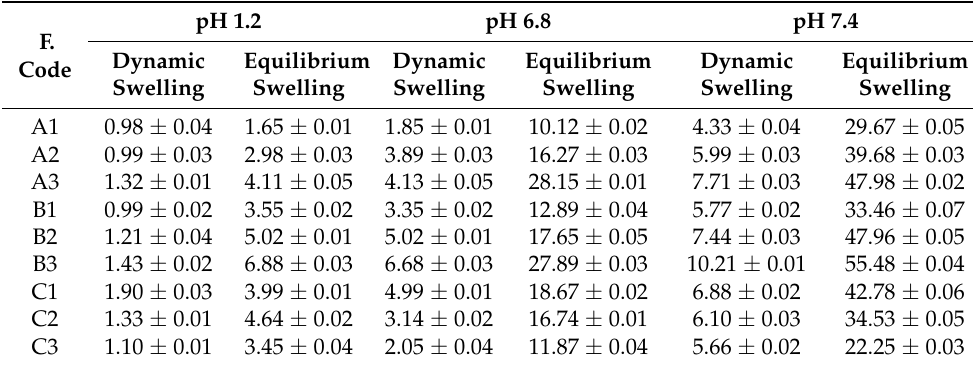
Table 2. % Dynamic and equilibrium swelling study of